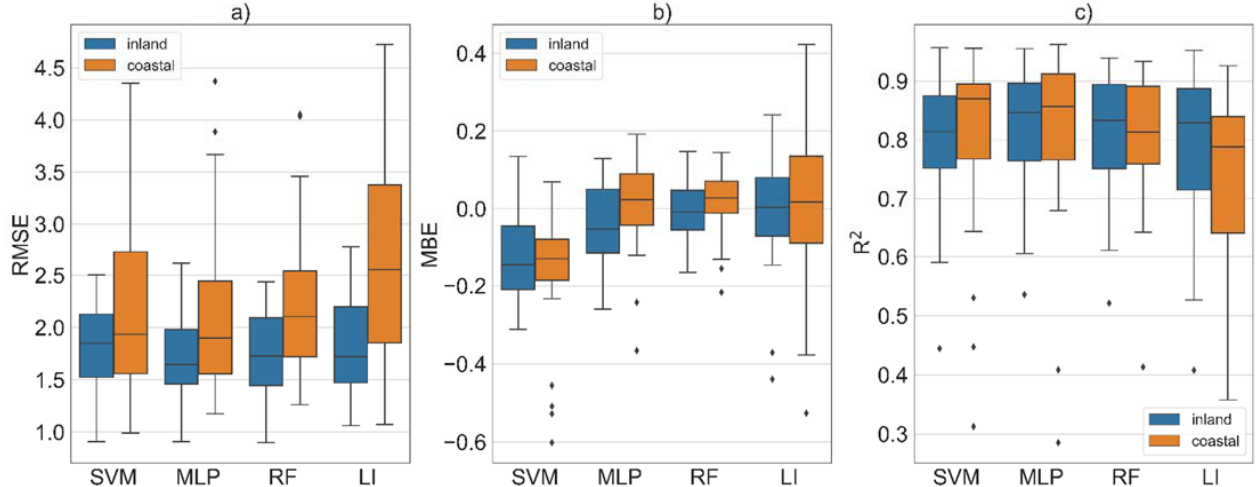
Figure 7. RMSE ( a ), MBE ( b ), and R 2 ( c ) values of the different models (SVM, MLP, and RF) in the coastal and inland locations, using rainfall values from neighbor stations as inputs, where the minimum, the first interquartile (Q1), the median, the third interquartile (Q3), the maximum, and the outlier values are represented. Table 8. Best improvements between simple arithmetic averaging and the best ML model from each site for R 2 and RMSE. A positive value means that ML outperformed